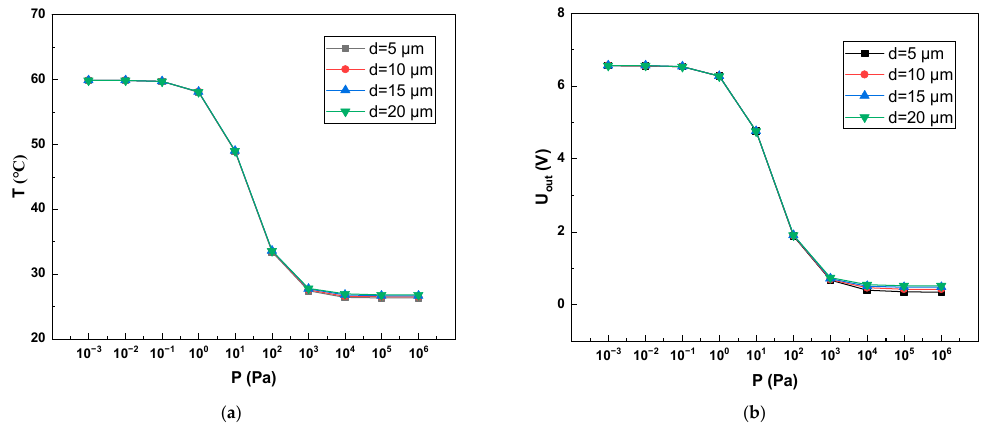
Figure 9. Range of Pirani gauge at different cavity depths. ( a ) Variation of Pirani gauge VOx temperature with pressure at different cavity depths; ( b ) Variation of Pirani gauge output voltage with pressure at different cavity depths.